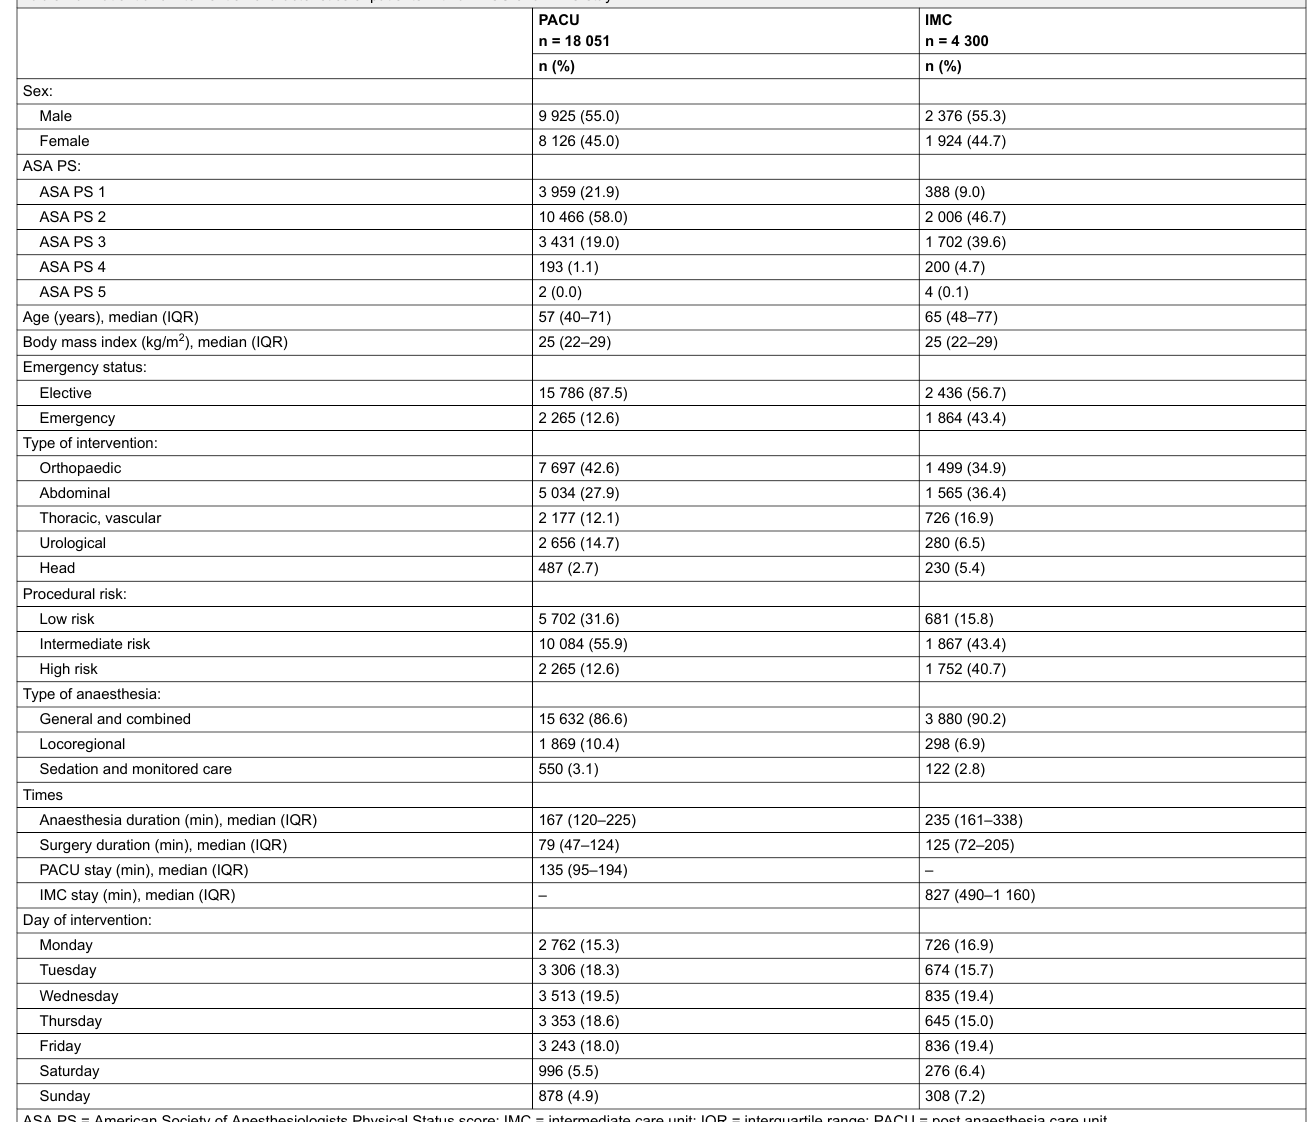
Table 1b: Patient and intervention characteristics of patients with a PACU or an IMC